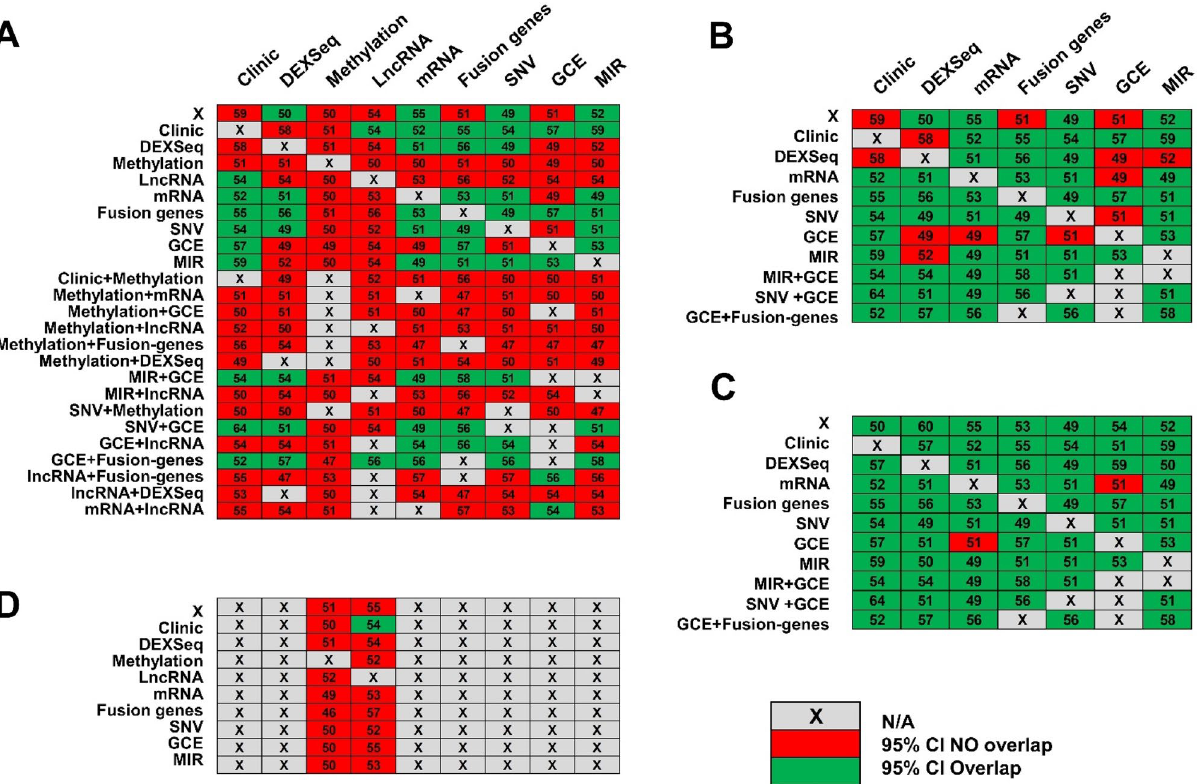
Figure 4. Validation of UI prediction models of response to treatment in TCGA datasets. The columns represent different types of clinical and molecular data: DEXSeq (individual exon expression), Methylation (DNA methylation), LncRNA (long non-coding RNA expression), mRNA (gene expression), Fusion genes (presence of fusion genes), SNV (Single Nucleotide Variation), GCE (gene copy estimation), and MIR (microRNA expression). The rows also represent different types of data, either individually or in combination. ( A ) Validation of all prediction models of response in TCGA: Models containing DNA methylation and lncRNA data underperformed: AUC 95% CIs of TCGA-validation models did not overlap with AUC 95% CIs of UI-built training models (red cells in the graphic). Green cells represent those AUC 95% CIs of TCGA-validation models that overlap with UI-built AUC 95% CIs. ( B ) When we removed models containing DNA methylation and lncRNA data, 80% of CIs from UI-built training models overlapped with CIs from TCGA-validation models. ( C ) When prediction models without DNA methylation and lncRNA data were adjusted with genotyping data (as detailed in in Supplementary Methods), 97% of CIs from UI-built models overlap ped with CIs of TCGA- validation models. ( D ) TCGA-validation performance did not improve when adjusting for different genotypes between UI and TCGA. This was tested in models with 1 and 2 types of data (18